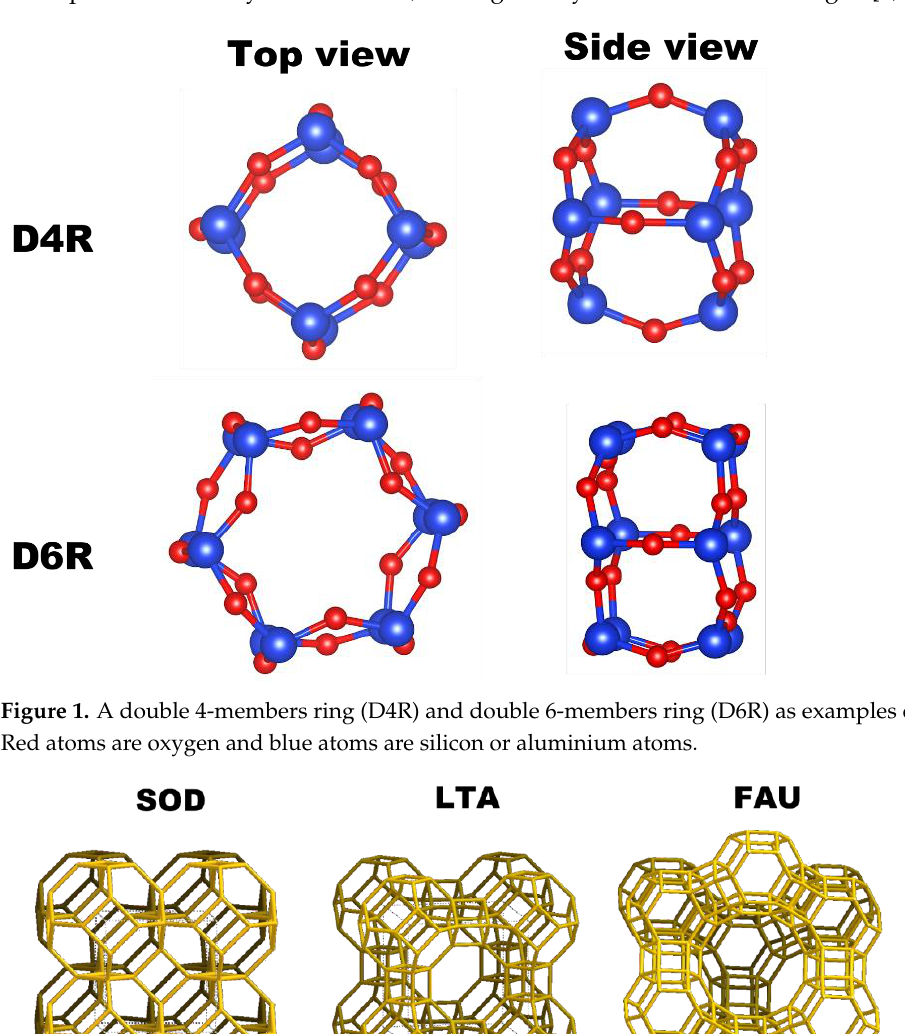
Figure 2. The framework structure for SOD (left), LTA (middle) and FAU (right) zeolitic network.